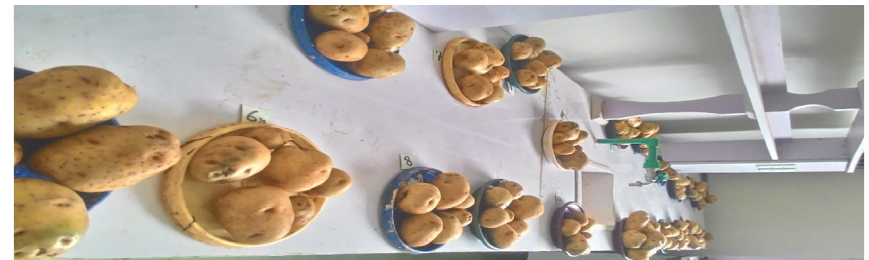
Figure 2: Grading and tube size distribution photo.